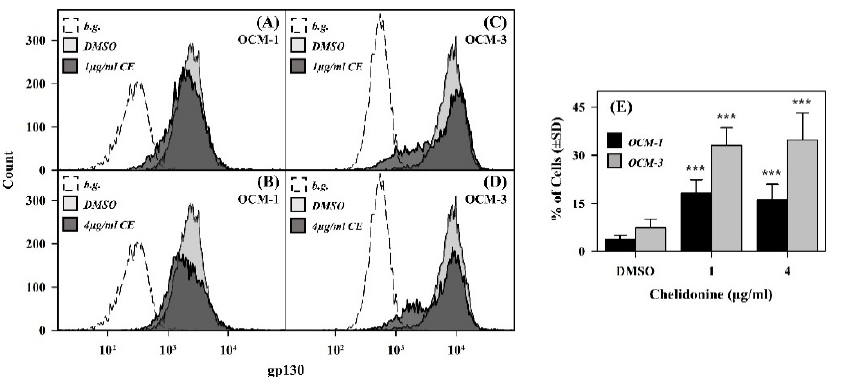
Figure 4. Chelidonine decreases the expression of gp130 in the cell membrane in OCM-1 and OCM-3 cell lines. ( A – D ) Representative flow cytometric histograms demonstrating the expression level of gp130 receptor subunits in DMSO- (light grey) and chelidonine-treated (dark grey) cells. The unlabeled DMSO-only-treated cells are depicted as empty dashed histograms. ( E ) Percentages of cells with reduced gp130 expression (OCM-1: black bars; OCM-3: grey bars). Percentages are expressed as mean ± SD values for at least three independent experiments, p < 0.001 (***). Cells treated with chelidonine (1 or 4 µ g/mL) or DMSO for 24 h were stained with PE-conjugated mAb specific for gp130 and analyzed by flow cytometry (n = 10,000 cells/sample). (b.g.: background, CE: